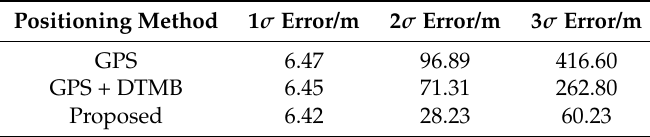
Figure 26. RPE of the three methods at each test point at Site 2: ( a ) RPE in x axis direction of the ECEF system; ( b ) RPE in y axis direction of the ECEF system; and ( c ) RPE in z axis direction of the ECEF system. Table 5. Errors of different positioning methods at Site 2.